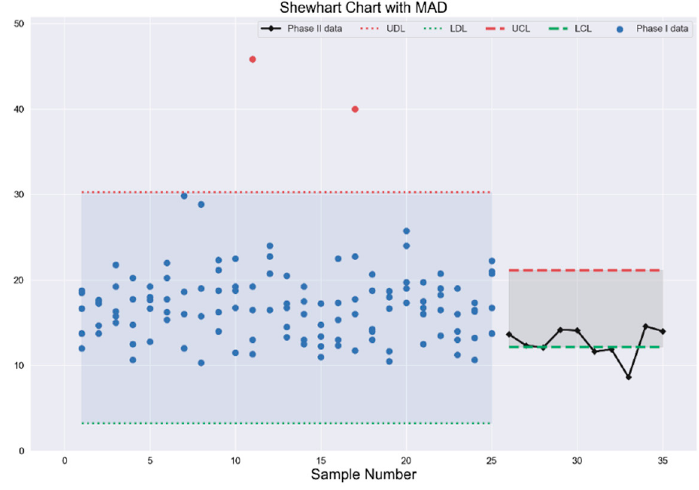
Figure 11. Scatter plot of phase-I sample and the resulting Shewhart chart with MAD-outlier detection screening.